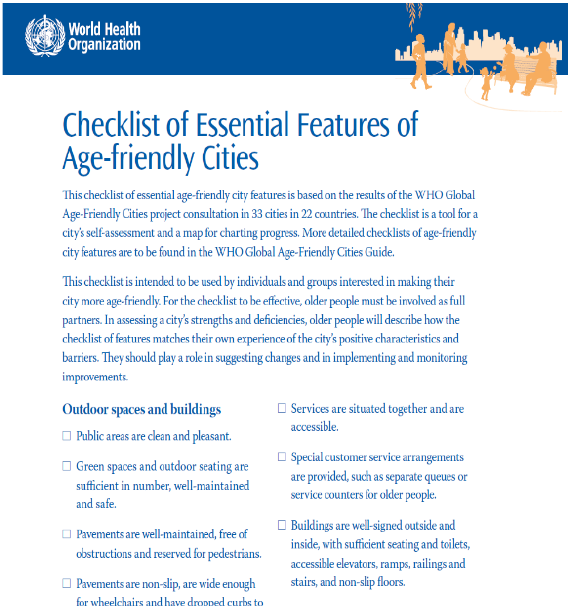
Figure 2. Checklist (WHO,